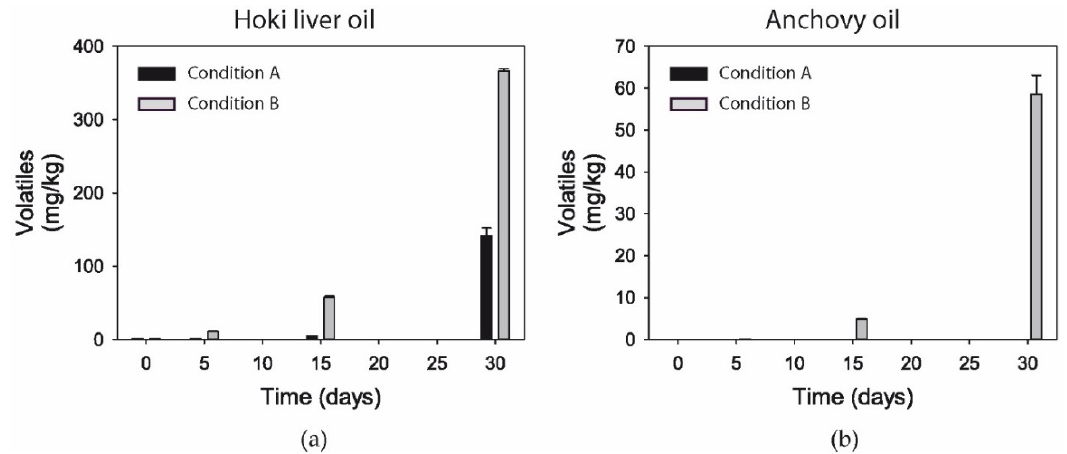
Figure 4. Total concentration of the five volatiles combined in ( a ) hoki liver oil and in ( b ) anchovy oil over a 30-day period under oxidation condition A (black bars) and condition B (gray bars). Results are means ± S.D. of three technical replicates for three parallel